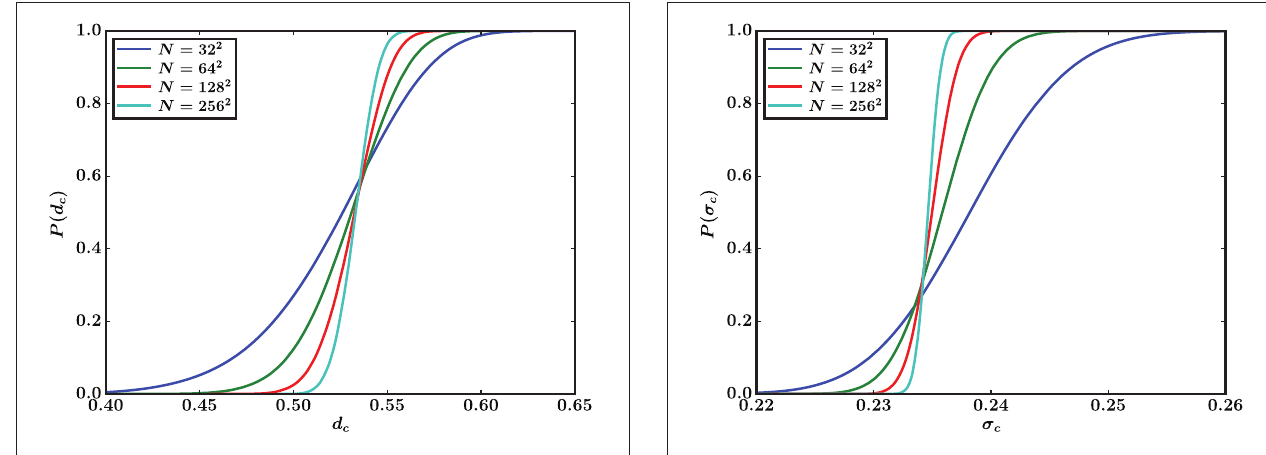
shows the corresponding values for LLS on a square lattice. As N → ∞ the LLS critical strength converges toward σ c ≈